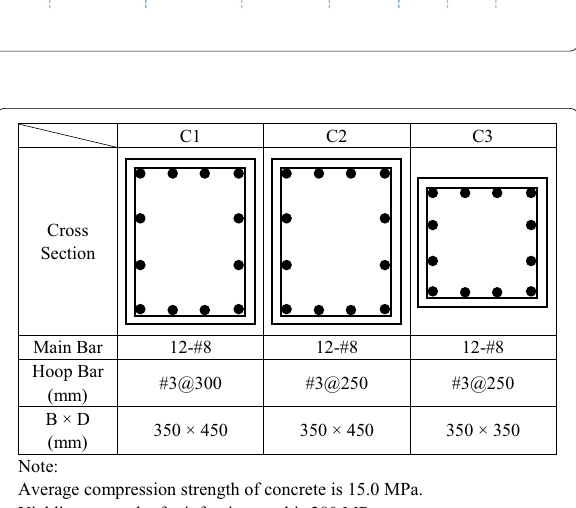
Fig. 22 Damage levels of damaged column members.